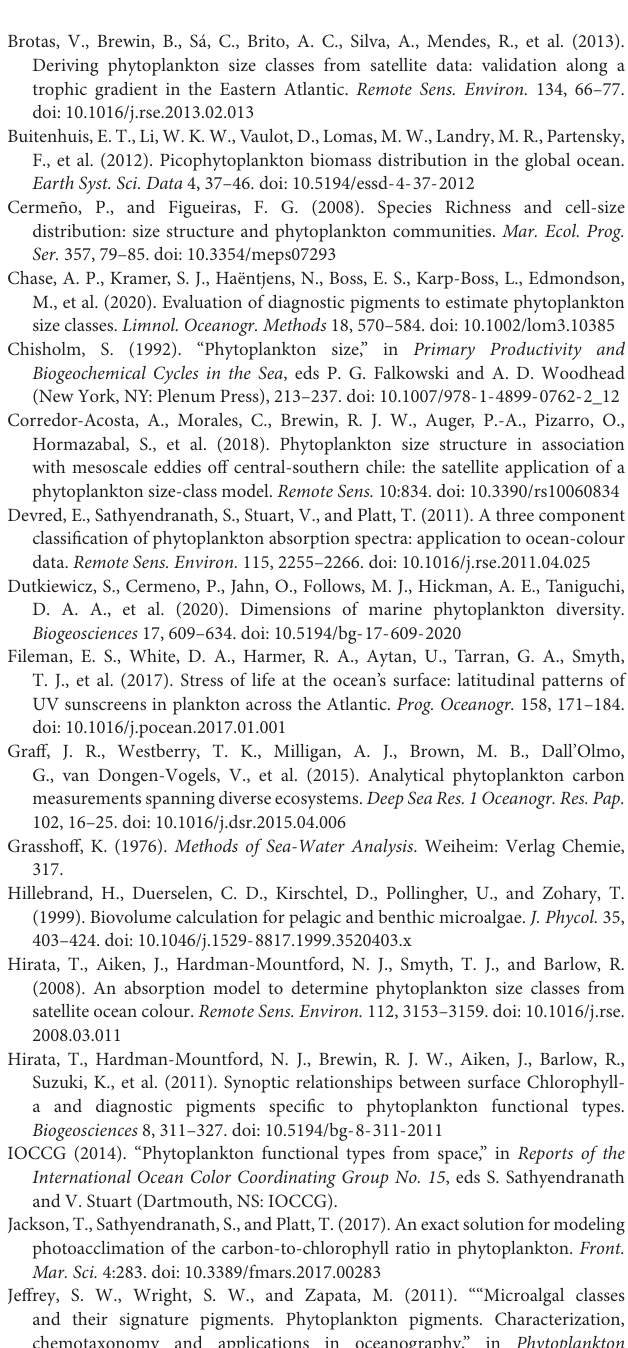
Supplementary Table 1 | List of species found and their abundances per sampling station (cell abundances determined by microscopy, and expressed in carbon). The codes of column A are the same as indicated by Sal et al.